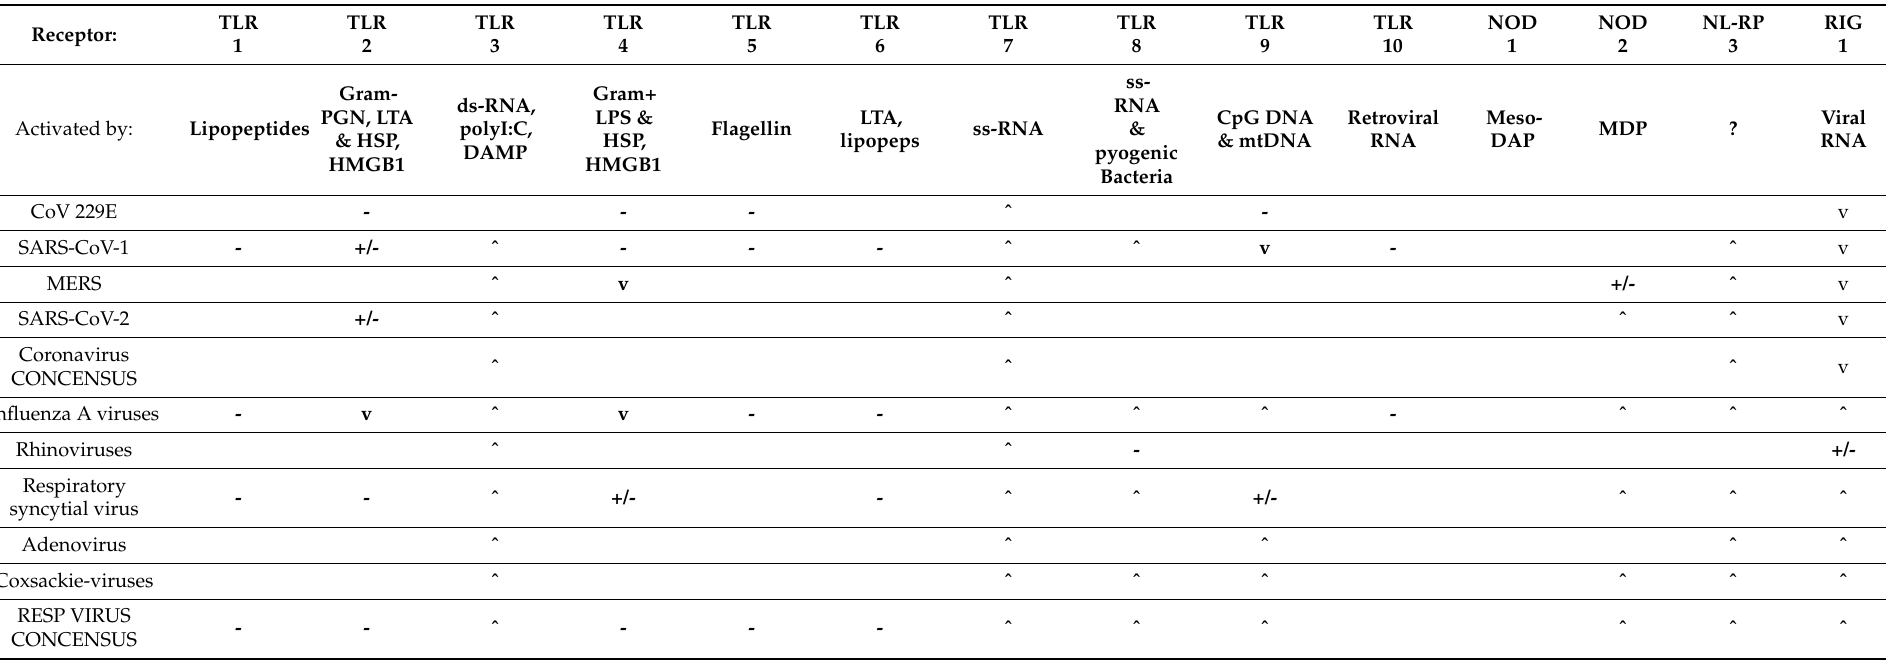
Table 2. Summary of studies quantifying the increased activation or protein expression of TLR and NLR for innate immune system cells following viral infections. CoV229E = coronavirus type 229E (a cold virus); SARS-CoV-1 = severe acute respiratory syndrome coronavirus type 1; MERS = Middle East respiratory syndrome virus; SARS-CoV-2 = severe acute respiratory syndrome coronavirus type 2 and RESP = respiratory. Blank squares indicate that no data were found regarding the activity or expression pattern of the receptor. – indicates no change, ˆ indicates increased activation or protein expression, V indicates downregulation or decreased protein expression, +/- indicates conflicting reports about whether there is increased activity or protein expression and -/V indicates conflicting reports about whether there is no change or downregulation. PGN = peptidoglycan; LTA = lymphotoxin alpha; HSP = heat shock protein; HMGB1 = High Mobility Group Box 1 protein; dsRNA = double-stranded ribonucleic acid; polyI:C = polymer composed of inosine and cytosine; DAMP = damage-associated proteins; Gram+ = expressed by Gram-positive bacteria; lipopeps = lipopolypeptides; ssRNA = single-stranded ribonucleic acids; CpG DNA = deoxyribonucleic acid high in cytosine and guanine, typifying a microbial genomic origin; mtDNA = deoxyribonucleic acid derived from mitochondria; DAP = diaminopimelic acid, a bacterial cell wall component; MDP = muramyl dipeptide, a bacterial cell wall component and ? = activators not presently